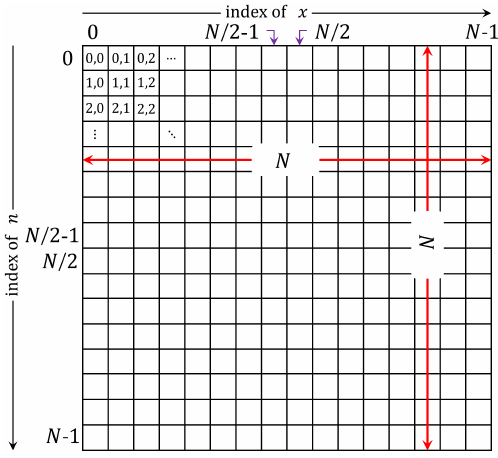
Figure 1. The 2D array parameters of